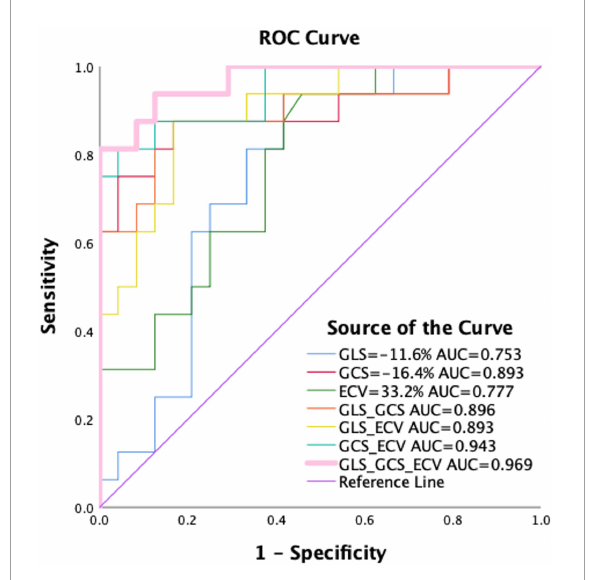
FIGURE6 Receiver operating characteristics curve for GLS, GCS, and ECV mapping and pairwise parameter for differentiating between Mayo I/II AL amyloidosis and HCM patients. As shown, a GCS < –16.4%, GLS < –11.6%, or ECV > 33.2% could predict Mayo I/II amyloidosis from HCM patients. Among them, the combined diagnostic performance of GLS, GCS, and ECV mapping can well distinguish Mayo I/II AL amyloidosis patients from hypertrophic cardiomyopathy (AUC = 0.969, Youden index = 0.813). HCM, hypertrophic cardiomyopathy patients; ECV, extracellular volume; GLS, global longitudinal strain; GRS, global radial strain; AUC, area under the curve.